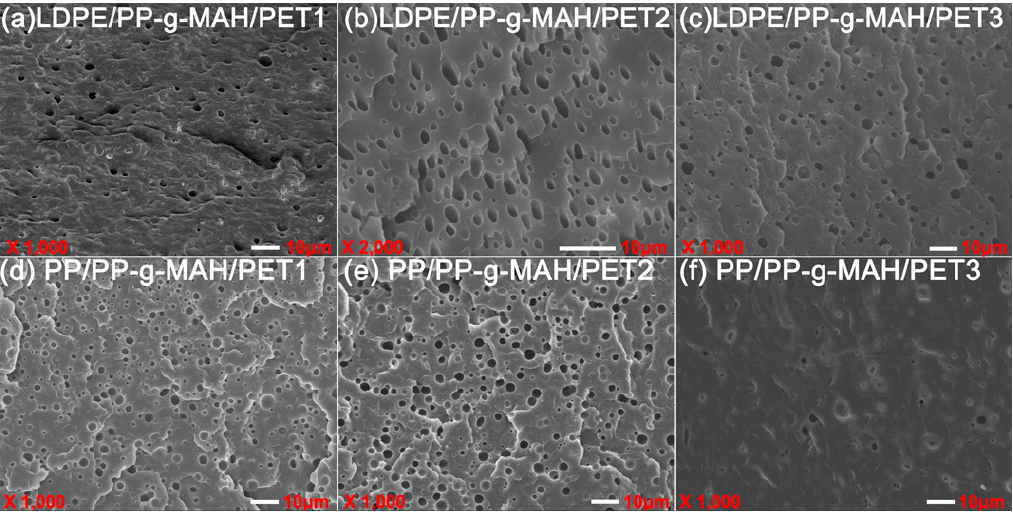
Figure 10. SEM micrographs of LDPE/PET ( a, b, c ) and PP/PET ( d, e, f ) blends with different IV of PET in the presence of compatibilizer (80/20/5).